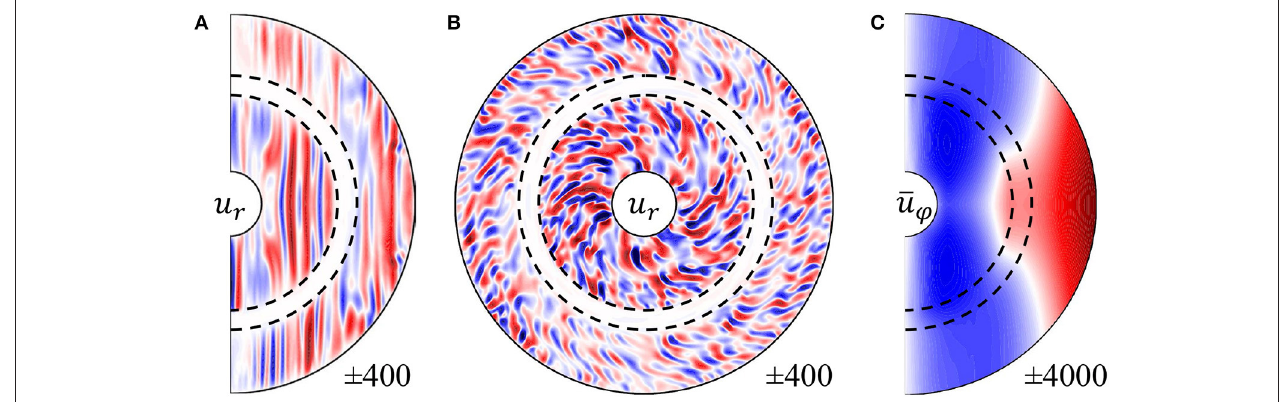
Frontiers in Earth Science |